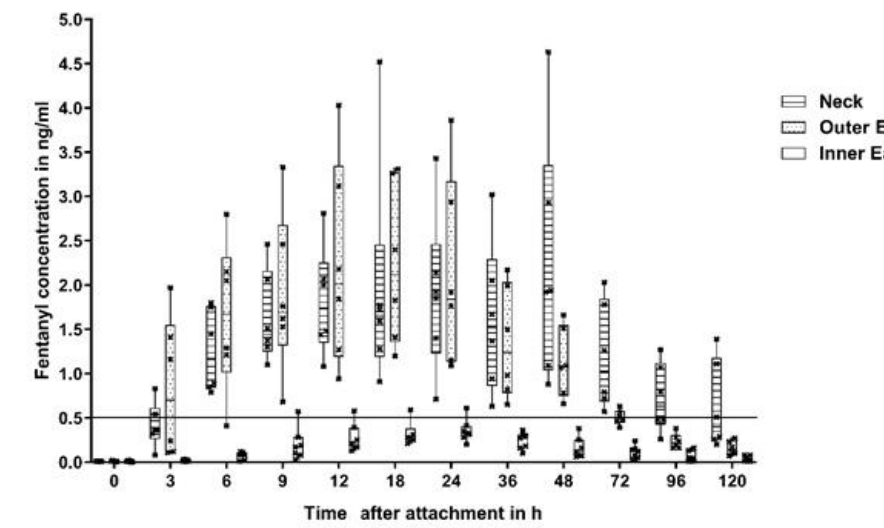
Figure 5. Fentanyl plasma concentrations of all groups.